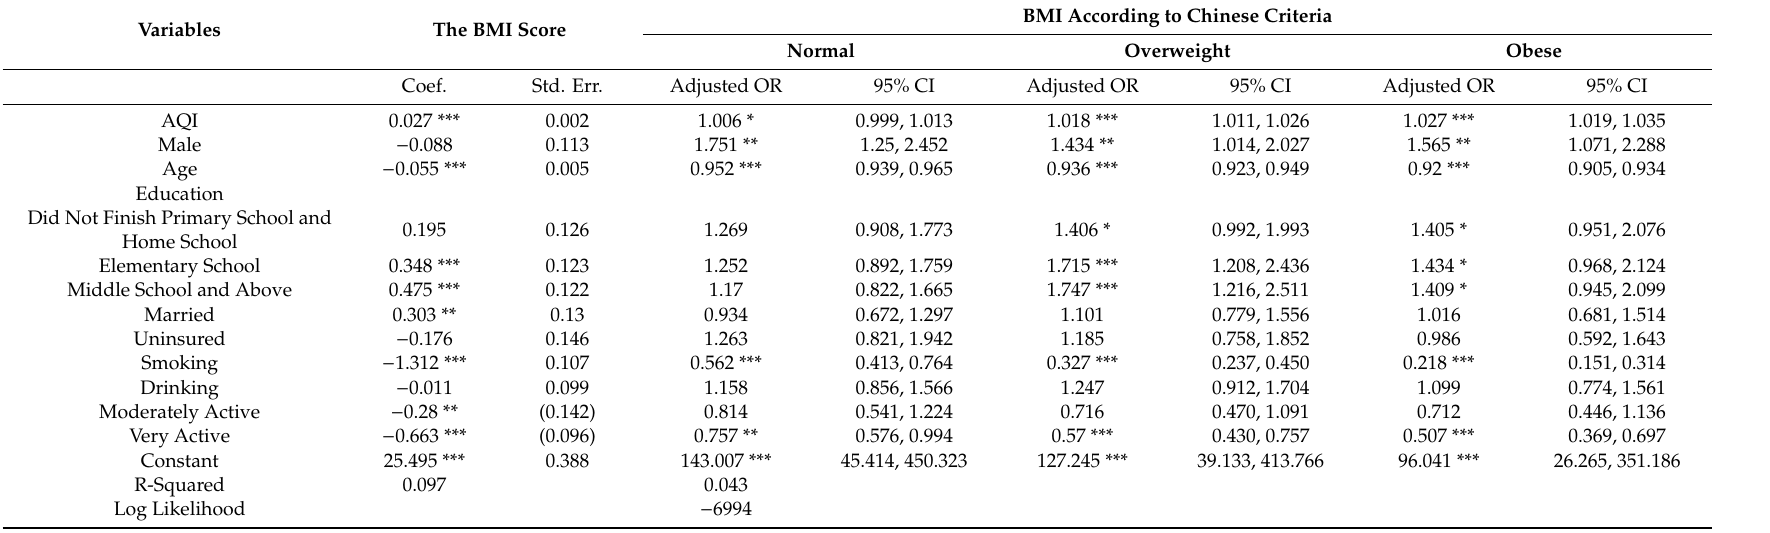
Table A1. E ff ect of Air Quality Index (AQI) on Body Mass Index (BMI): add physical activity variable.